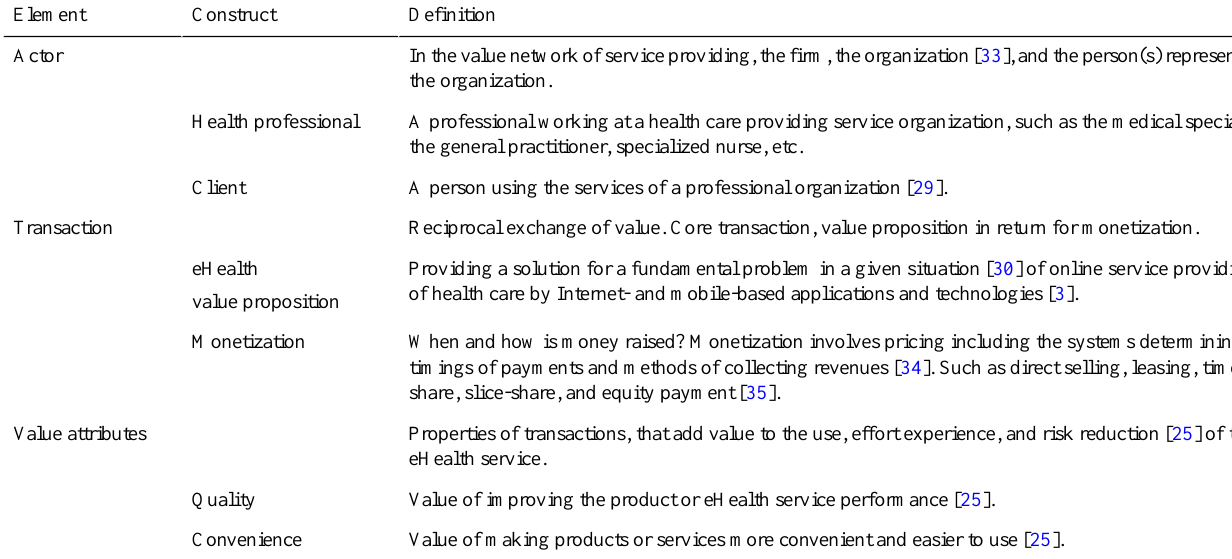
Table 1. Care model